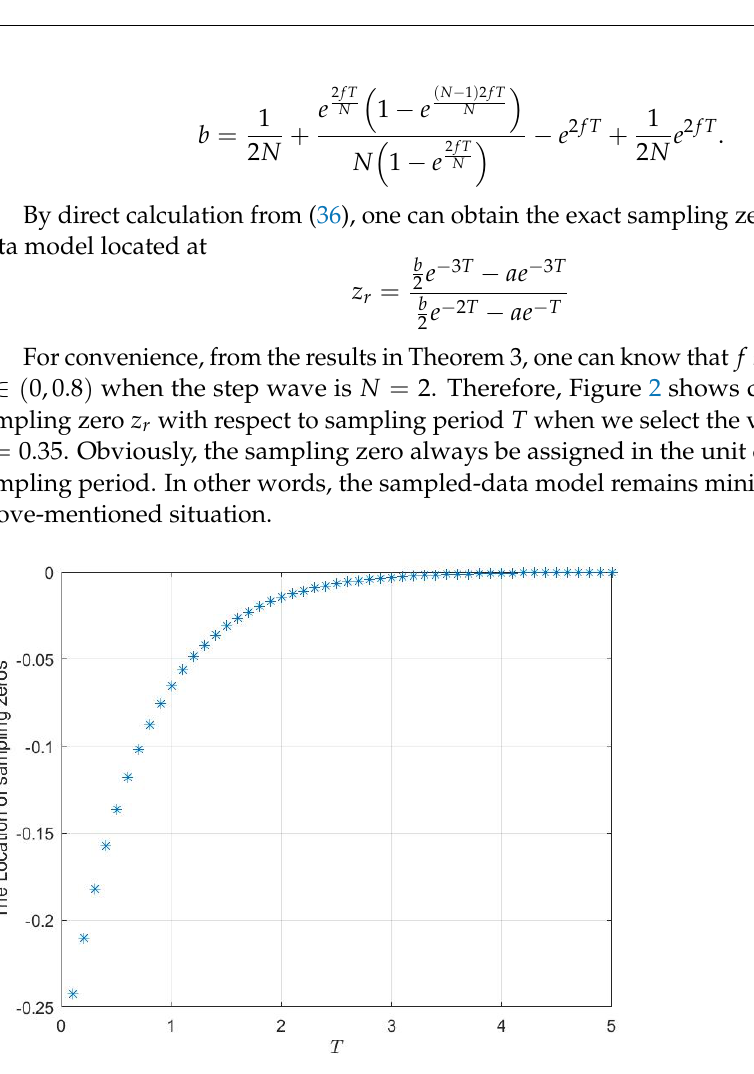
Figure 2. The asymptotic property of the sampling zero of a sampled-data model with ABTSH in the case of N = 2 and f =